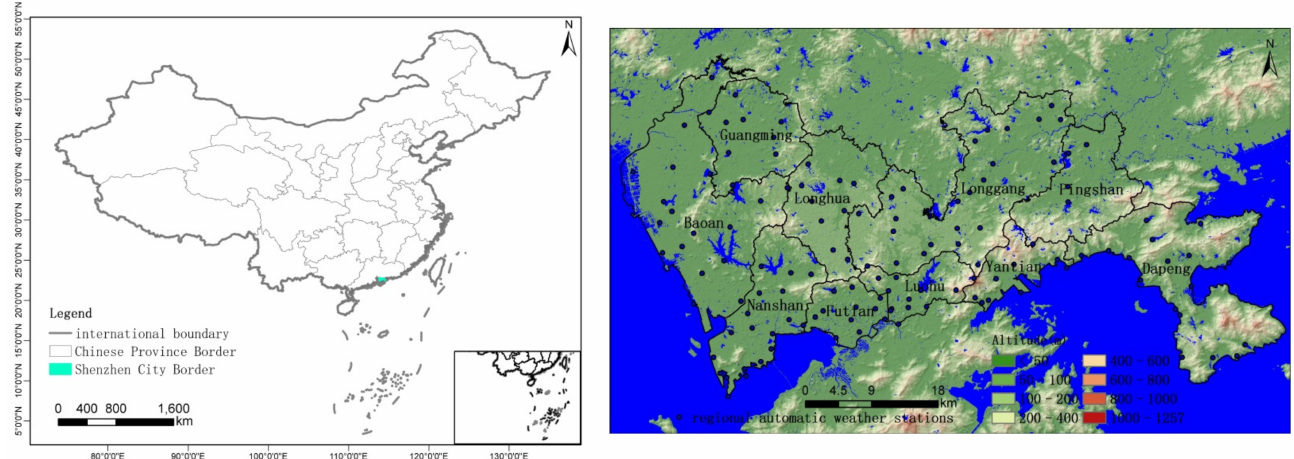
Figure 1. Geographical location and elevation distribution of